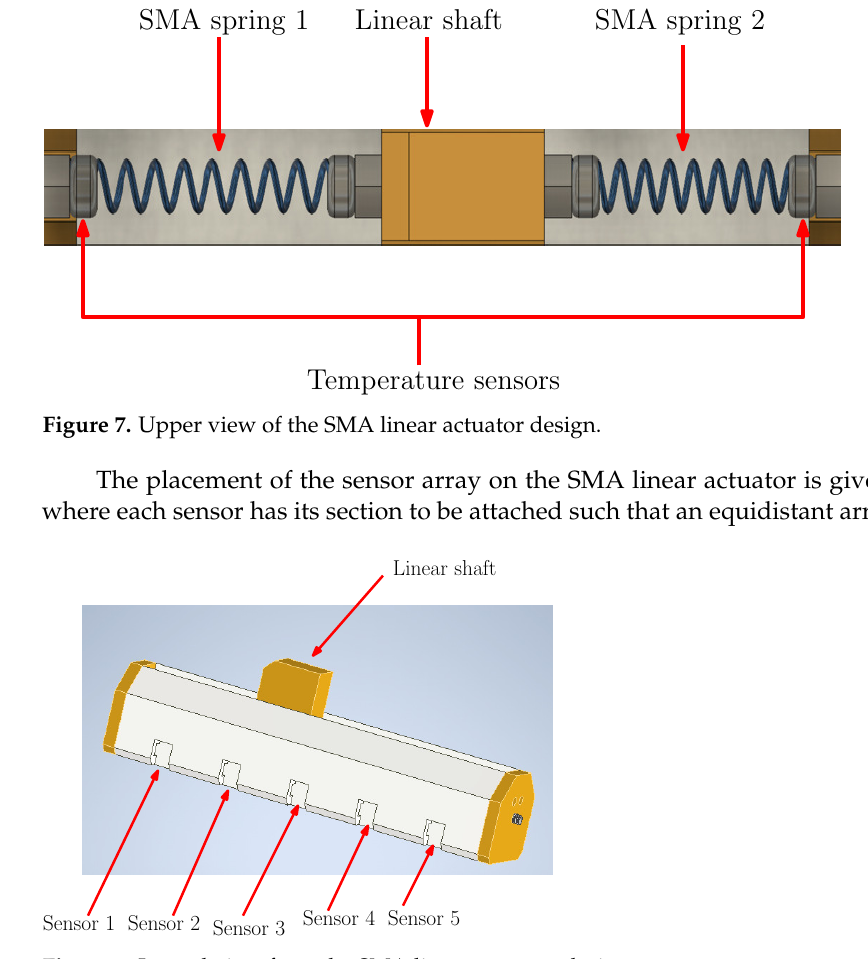
Figure 8. Lateral view from the SMA linear actuator